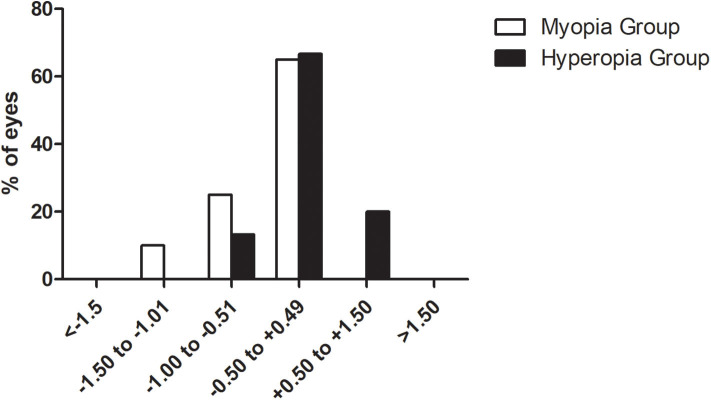
Overall satisfaction regarding vision quality before and after surgery.